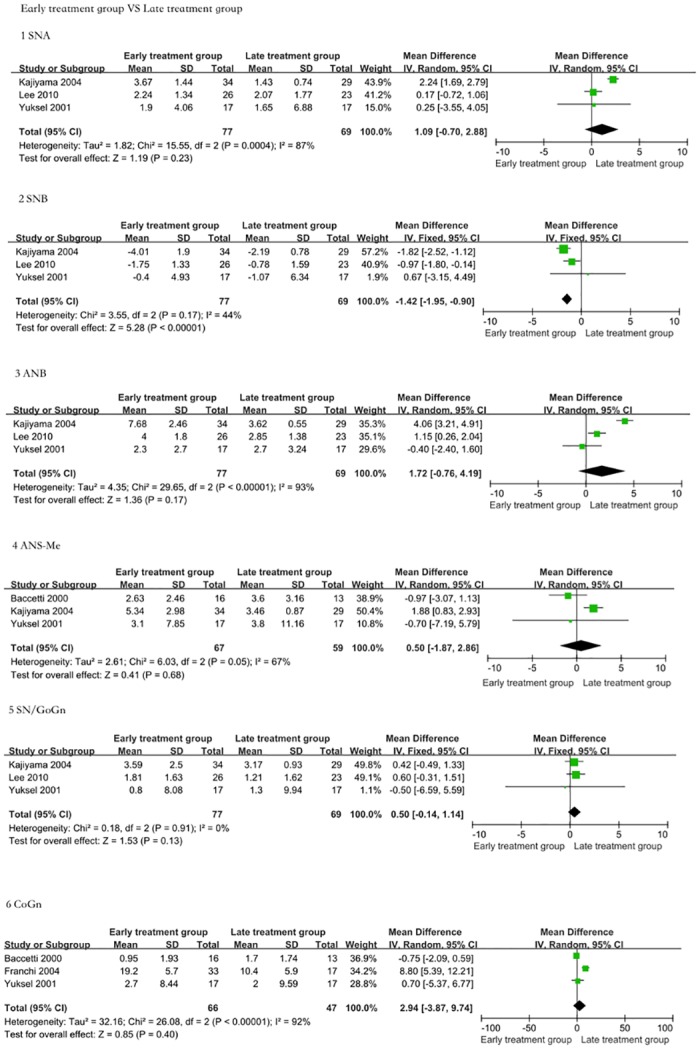
The efficacy assessment of early treatment for Class III malocclusion versus late treatment.The comparison was performed using five indices. 1: Angle SNA. The FM treatment group presented a greater increase in SNA than the controls (SMD = 1.09, 95% CI = -0.70–2.88, P = 0.23). 2: Angle SNB. The FM treatment group presented a greater decrease in SNB than the untreated controls (SMD = -1.42, 95% CI = -1.95–-0.90, P < 0.00001). 3: Angle ANB. The FM treatment group presented a greater increase in ANB than the controls (SMD = 1.72, 95% CI = -0.76–4.19, P = 0.17). 4: ANS-Me length. There were no significant differences in ANS-Me length between the early treatment group and the late treatment group (SMD = 0.50, 95% CI = -1.87–2.86, P = 0.68). 5: SN/GoGn angle. There were no significant differences in SN/GoGn angle between the early treatment group and the late treatment group (SMD = 0.5, 95% CI = -0.14–1.14, P = 0.13). 6: Co-Gn length. There were no significant differences in Co-Gn length between the early treatment group and the late treatment group (SMD = 2.94, 95% CI = -3.78–9.74, P = 0.4). The maxillary protraction effect of the two treatment groups was similar.